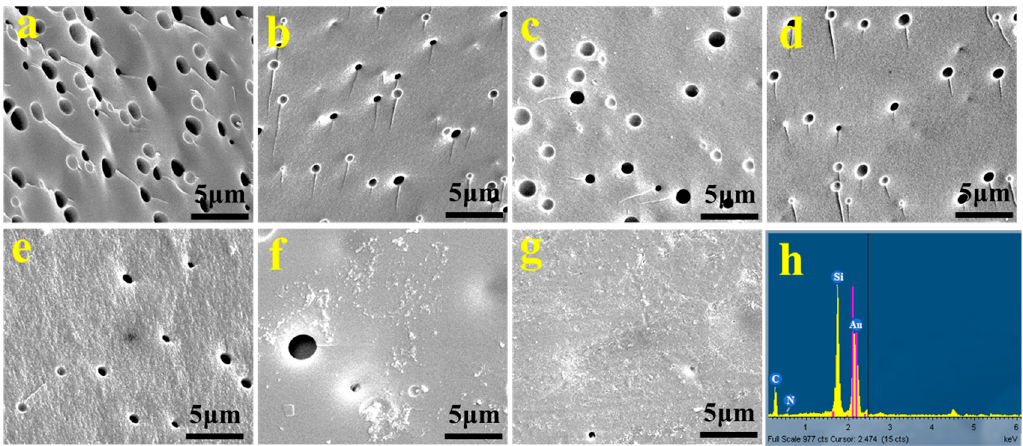
Figure 2. SEM images of all samples prepared with different acetone content after pyrolyzing and EDS energy spectrum after pure PCS pyrolyzing. ( a ) without acetone, ( b ) 1 wt.%, ( c ) 2 wt.%, ( d ) 5 wt.%, ( e ) 10 wt.%, ( f ) 30 wt.%, ( g ) 40 wt.%, and ( h ) EDS energy spectrum of ( a ).